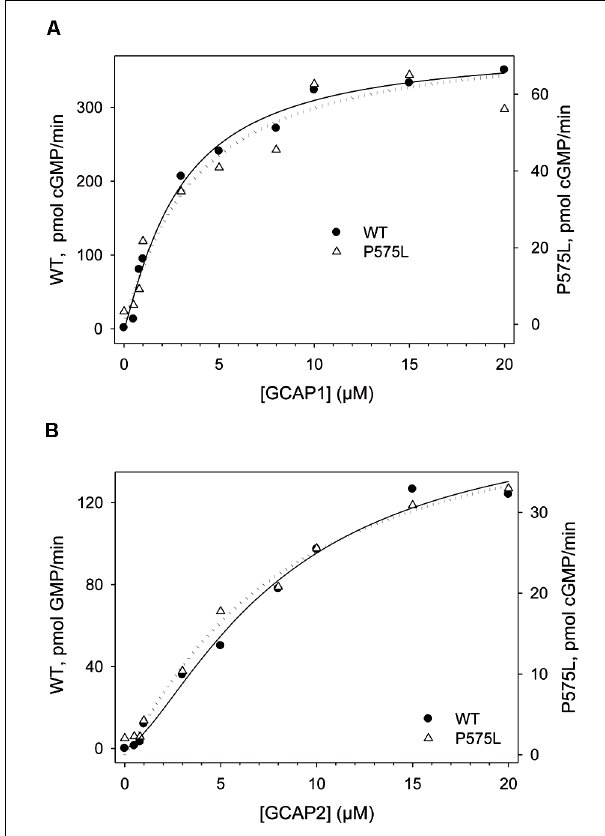
FIGURE 5 | GCAP-dependency ofWT and P575L to determine apparent affinities (EC 50 ). WT and mutant P575L (see inset) were incubated with Ca 2 + -free (Mg 2 + -bound) GCAP1 (A) and GCAP2 (B) .The amount of cGMP produced by ROS-GC1 is shown as a function of the GCAP concentration. Incubation time was 30